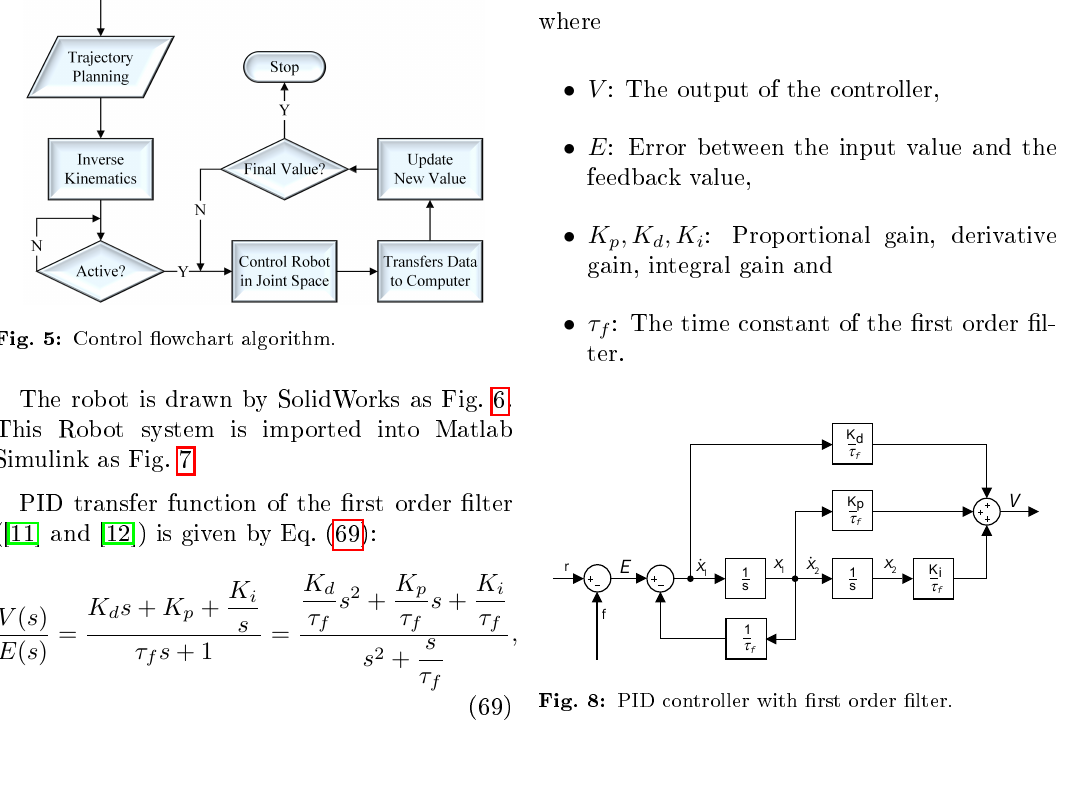
Fig. 8: PID controller with (cid:28)rst order